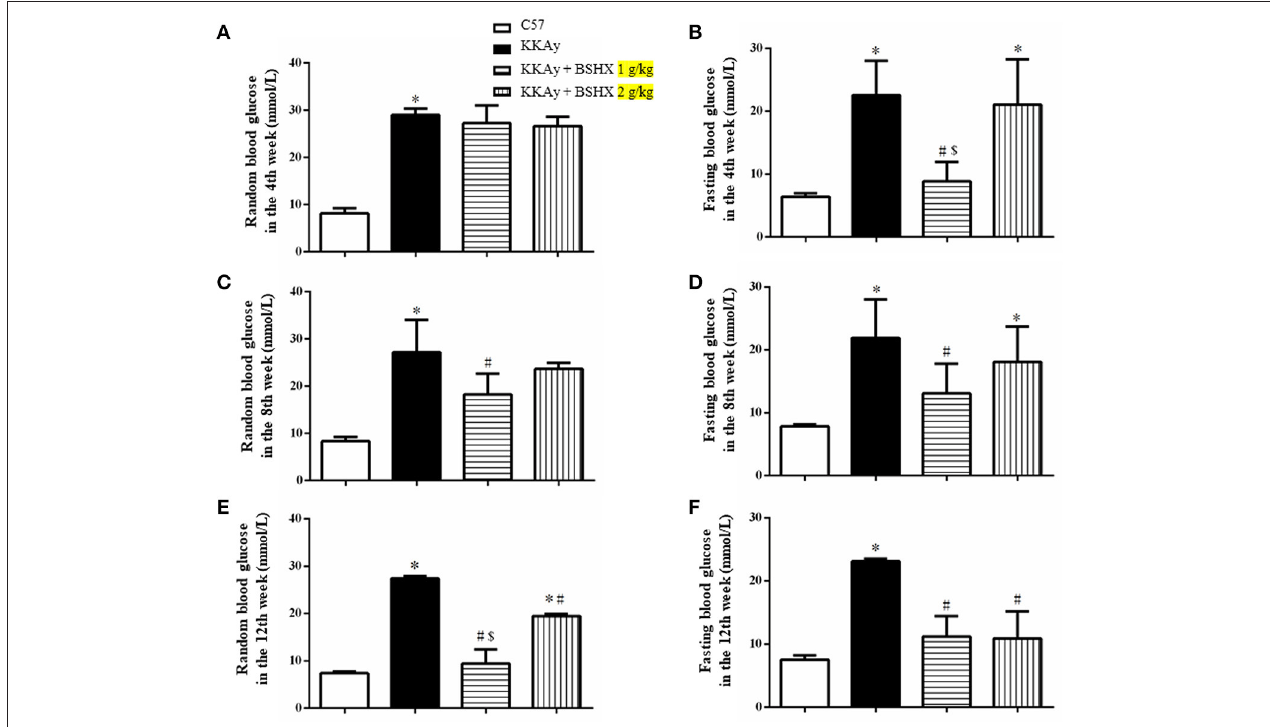
FIGURE 1 | The effect of BSHX on blood glucose levels. Treatment of KKAy mice with BSHX for 4 (A,B) , 8 (C,D) , and 12 weeks (E,F) reduced random and fasting levels of blood glucose. Data were expressed as mean ± SD ( n = 6). * p < 0.05 vs. C57 group, # p < 0.05 vs. KKAy group, $ p < 0.05 vs. KKAy + BSHX 2 g/kg group.